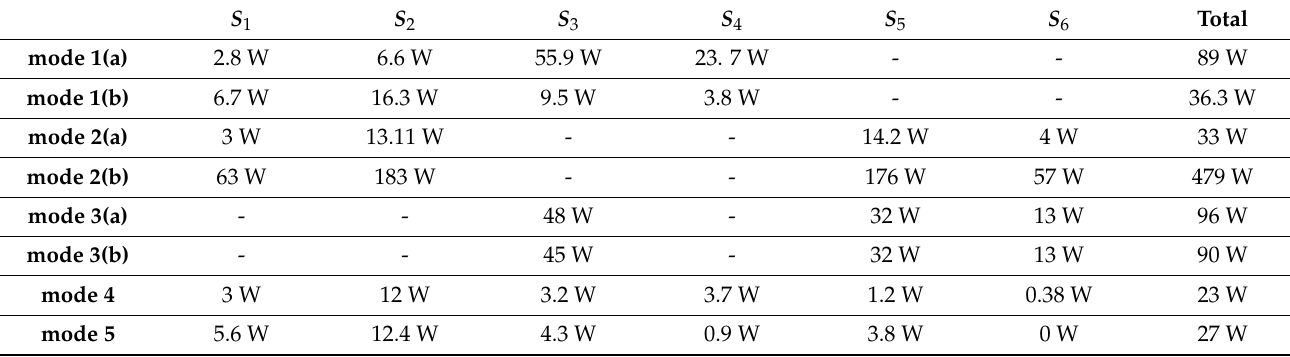
Table 6. Switching losses of the five operation